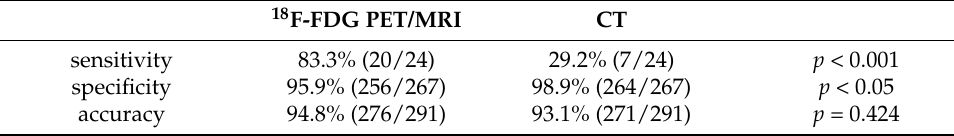
Table 3. Comparison of 18 F-FDG PET/MRI and CT for detecting lesion-based nodal